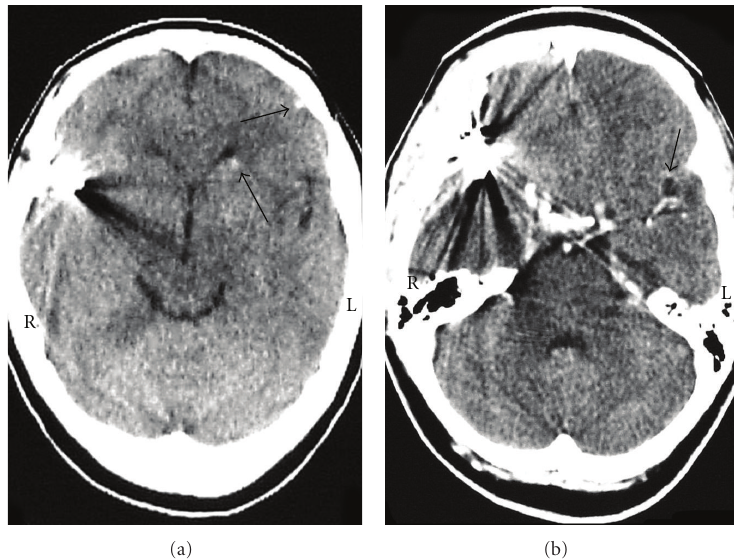
Figure 4: ( a) CT scan with no contrast after surgery showing calcifications (arrows). (b) Cyst (arrow) enhanced after contrast. (R: right, L: